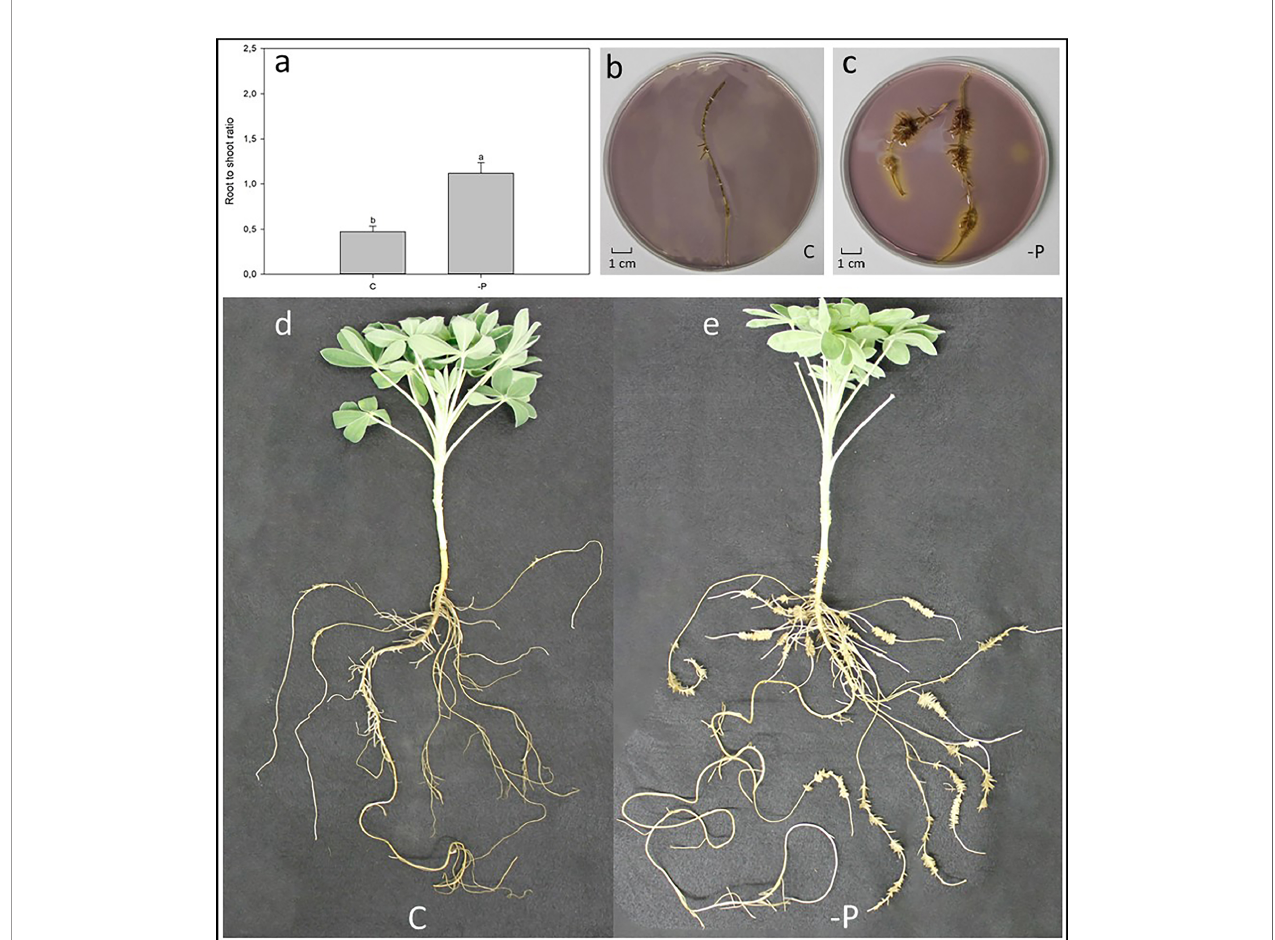
FIGURE 2 | Effect of P de fi ciency on 60-day-old white lupin plants. (A) Root-to-shoot ratio of white lupin plants grown in either control (C) or P starvation (-P) conditions; data are presented as mean ± SE, n = 10; lower case letters above the vertical bars indicate statistical signi fi cance according to t-test with p < 0.001. (B) Acidi fi cation of a C white lupins ’ cluster root laid in an agar gel mixed with pH indicator: yellow coloring indicates a lower pH than the purple color. (C) Acidi fi cation of a -P white lupins´ root laid in an agar gel mixed with pH indicator: yellow coloring indicates a lower pH than the purple color. (D) Representative white lupin plant grown in C condition. (E) Representative white lupin plant grown in -P